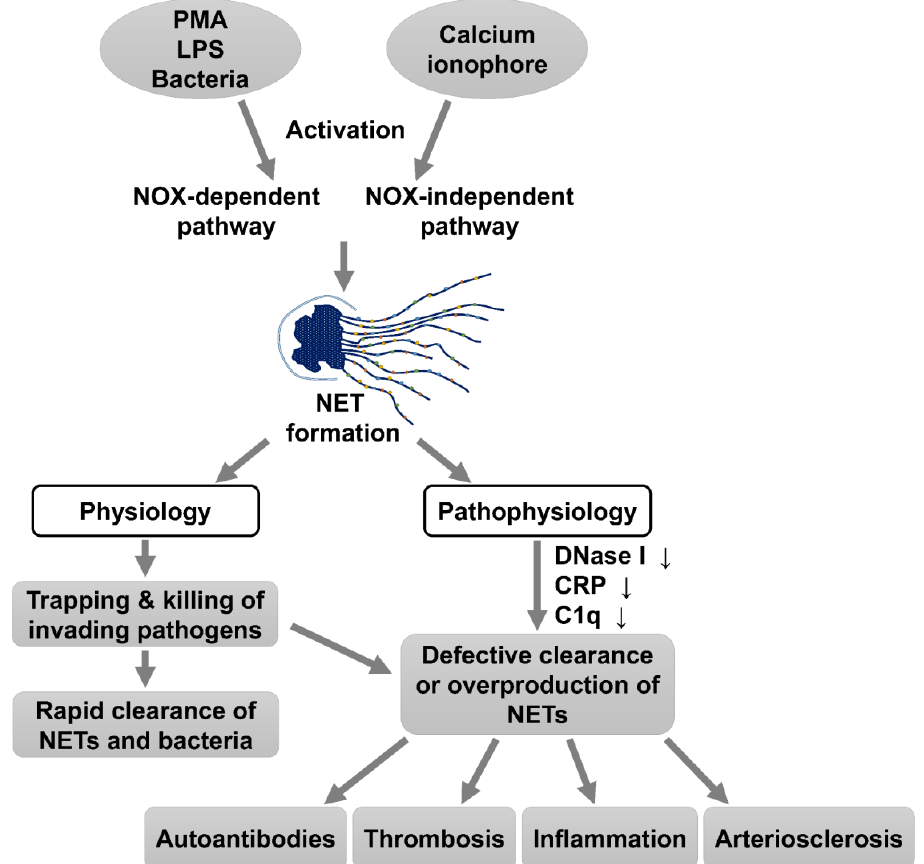
Figure 1. The induction and physiological/pathophysiological roles of NET formation in human diseases. Both NADPH oxidase (NOX)-dependent and -independent pathways are induced by different chemicals, bacteria, or molecules for NET formation. The physiological functions of NET formation aim to rapidly trap and kill the invading pathogens followed by clearance of NET via DNase I, C-reactive protein (CRP), and C1q. However, in some pathophysiological conditions such as the deficiency of these serum molecules or excessive NET formation, the released DNA, histone, and granule proteins become the neoantigens to stimulate autoantibody production, inflammation, and platelet entrapment. Subsequently, thrombosis, arteriosclerosis, and autoimmunity occur.